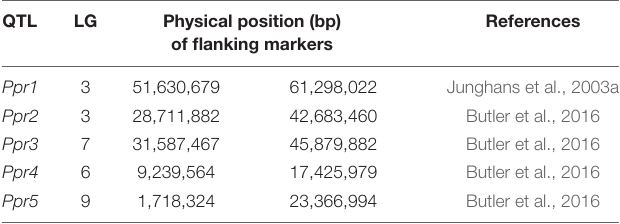
TABLE 2 | Austropuccinia psidii rust resistance QTL and their physical positions on linkage groups. QTL LG Physical position (bp) of flanking